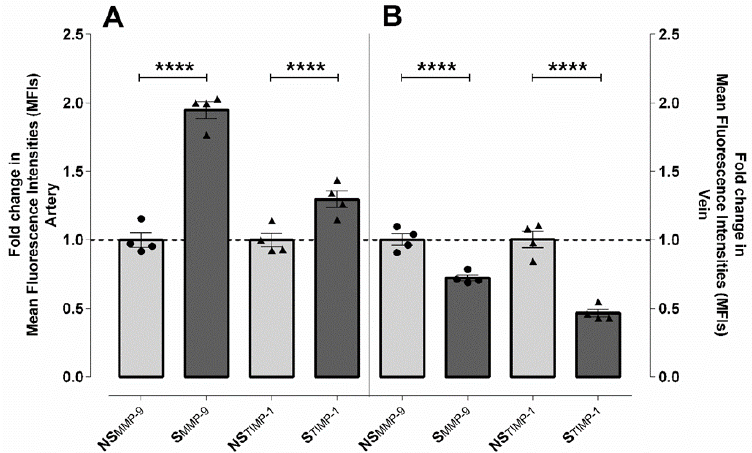
Figure 2. Expression of MMP-9 and its inhibitor, TIMP-1, in the endothelial layer of UC vessels with NS and S origins. Graphical representation of the immunohistochemical analysis showing the differences in mean fluorescence intensities (MFIs) between the arteries ( A ) and veins ( B ) of the NS and S samples (mean ± SEM). Each point on the graph indicates independent samples; NS-MMP-9 (n = 144 arteries and 35 venous regions of interest from 4 individual samples); S-MMP-9 (n = 245 arteries and 26 venous regions of interest from 4 independent samples). NS-TIMP-1 (n = 430 arteries and 54 venous regions of regions from 4 independent samples); S-TIMP-1 (n = 424 arteries and 32 venous regions of interest from 4 independent samples). Statistical analysis was performed by using an unpaired t -test followed by a Mann–Whitney test to compare ranks (**** p ≤ 0.0001).